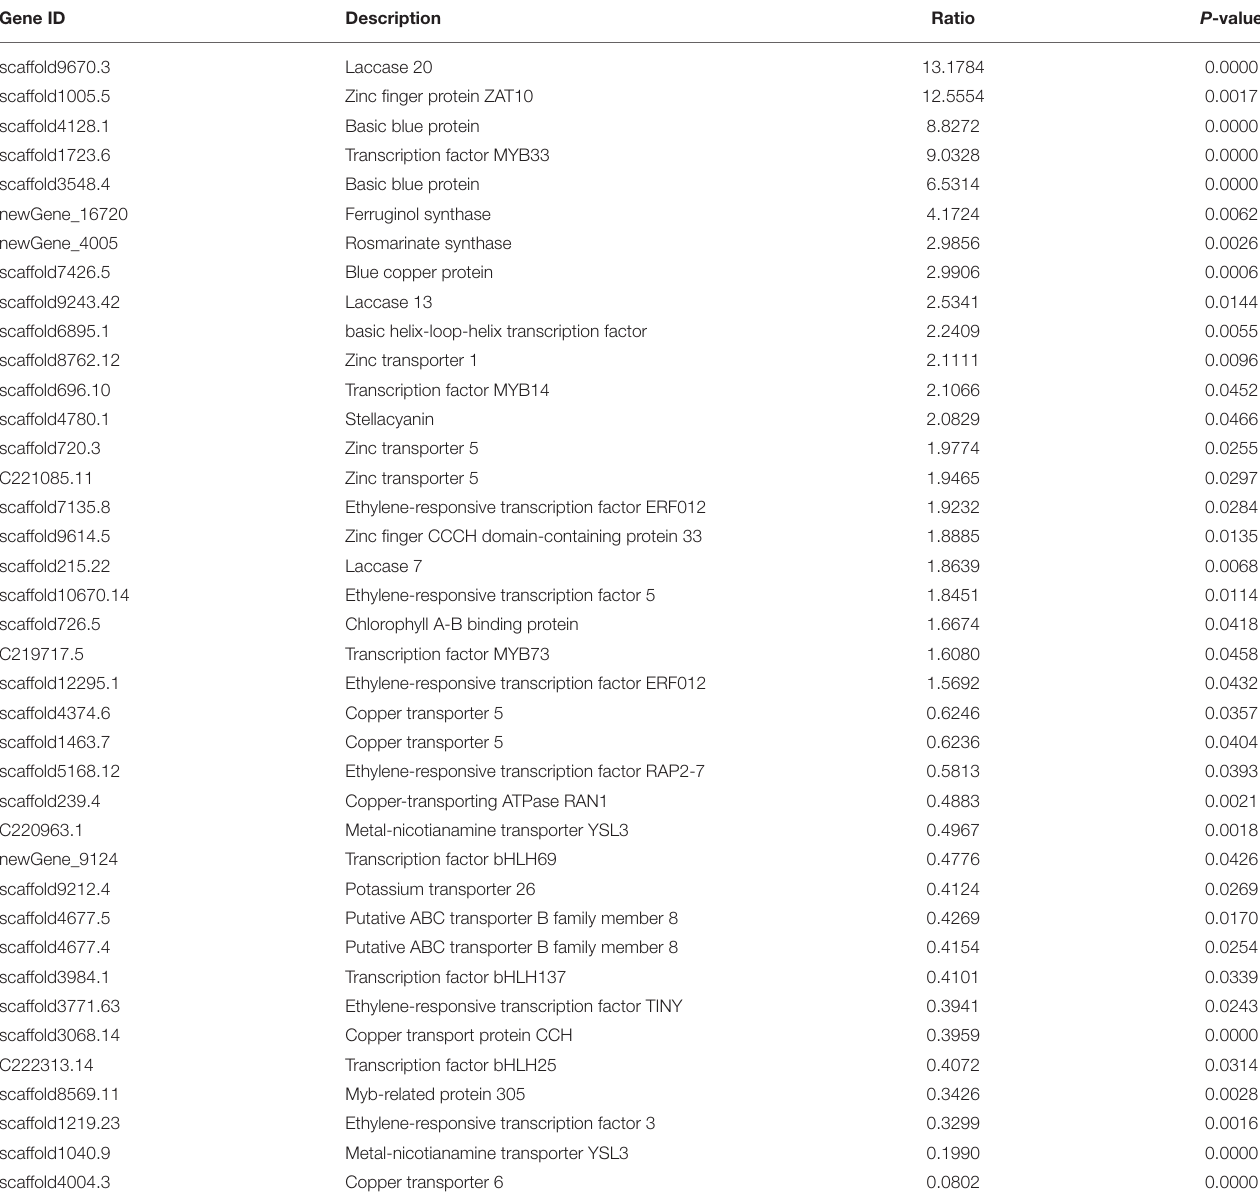
TABLE 1 | Key genes involved in salvianolic acid biosynthesis that showed a significantly change in abundance in leaves and roots of Salvia miltiorrhiza in response to treatment with a low concentration of copper